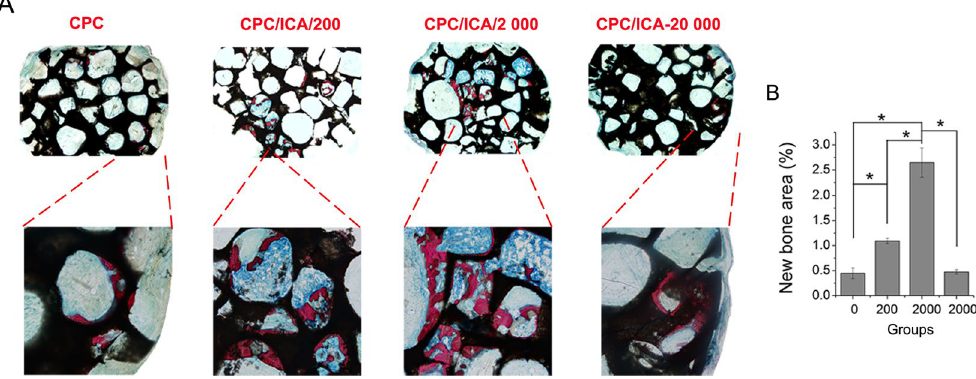
Figure 4. Osteogenic effect of local icariin on BMSCs in CPC scaffolds implanted in nude mice. On these nondecalcified sections, red areas represent newly formed bone, blue areas belong to collagen fibers, and black areas represent undegraded CPC scaffolds. ( A ) Histological images of bone formation for group CPC, CPC/ ICA-200, CPC/ICA-2 000, and CPC/ICA-20 000 (Line 1: × 40; Line 2: × 100); ( B ) The percentage of new bone area was assessed by histomorphometric analysis ( * p <